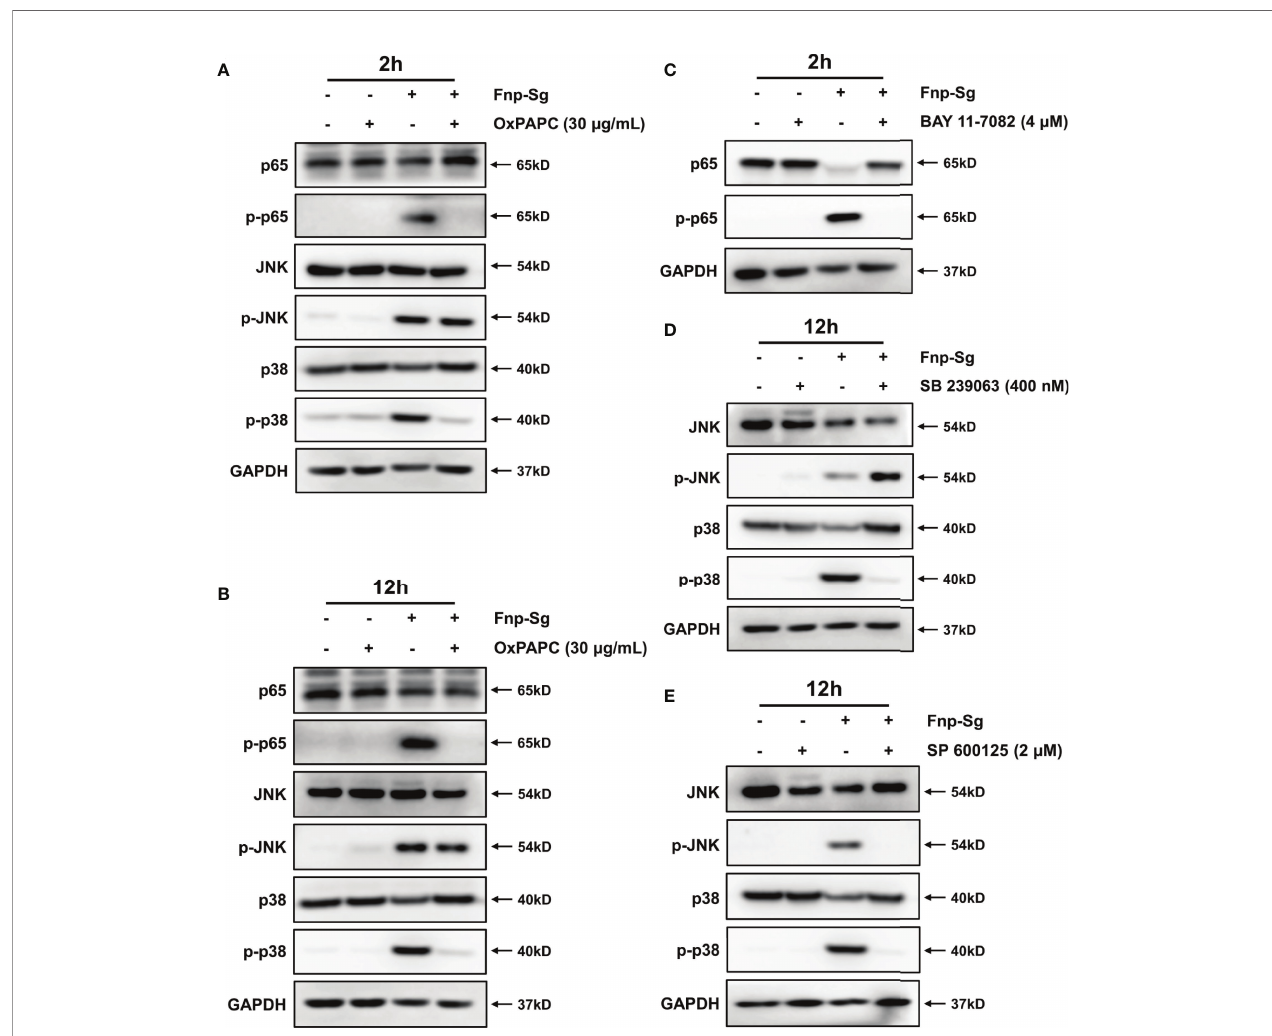
FIGURE 10 | The regulations of the NF- k B and MAPK signaling pathways in hGECs by coaggregation between F . nucleatum subsp. polymorphum and S. gordonii by western blot. hGECs were pretreated with the TLR2/4 antagonist OxPAPC for 2 h (A) and 12 h (B) , the NF- k B inhibitor BAY 11-7082 (B) for 2 h (C) , the p38 MAPK inhibitor SB 239063 for 12 h (D) and the JNK MAPK inhibitor SP 600125 for 12 h (E)